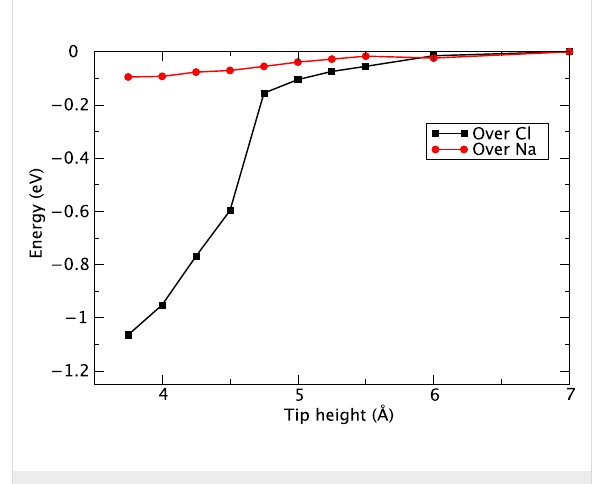
Figure 3: Energy as a function of tip height for the W tip interacting with the NaCl(001) surface.